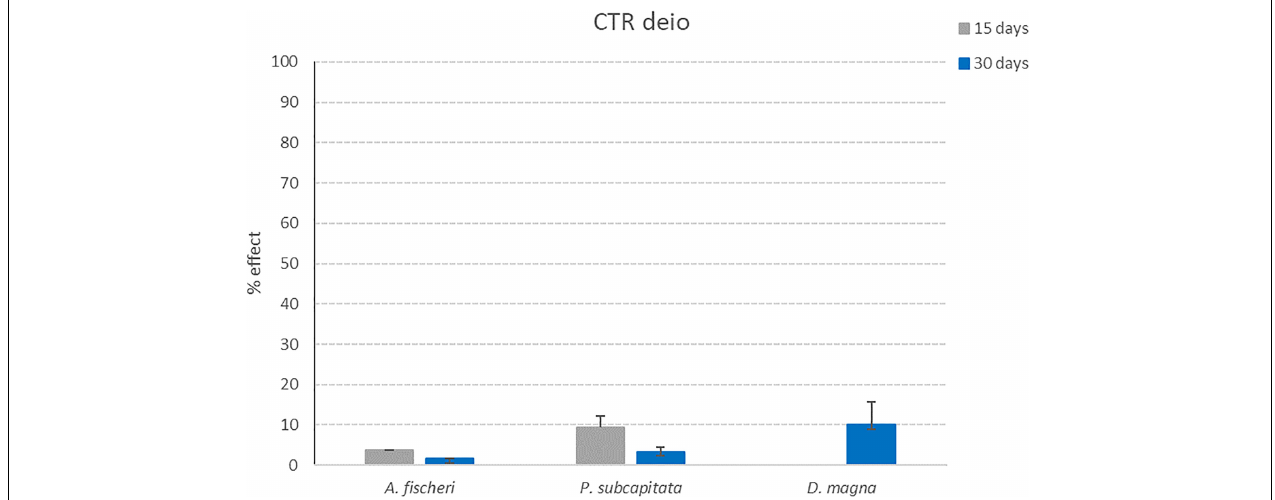
FIGURE 9 | Effect percentages obtained for CTR deio sample (deionized water without microplastics after 15 and 30 days of treatment with photocatalytic reactor) after exposure to the three model organisms ( A. fischeri ; P. subcapitata ; D. magna ). Bars indicate effect percentages recorded for the observed end-points (bioluminescence alteration; algal growth alteration; immobilization) for CTR deio sample collected after 15 (grey bars) and 30 days (blue bars) of treatment with the photocatalytic reactor (M ± ES; n = 3/4 for D. magna ).